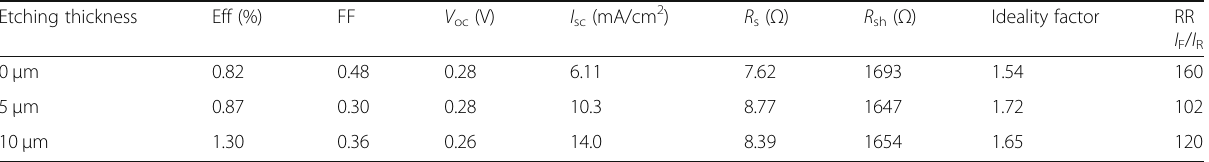
Table 2 Characteristics of SiNW solar cells with Al 2 O 3 removed by CMP Etching thickness